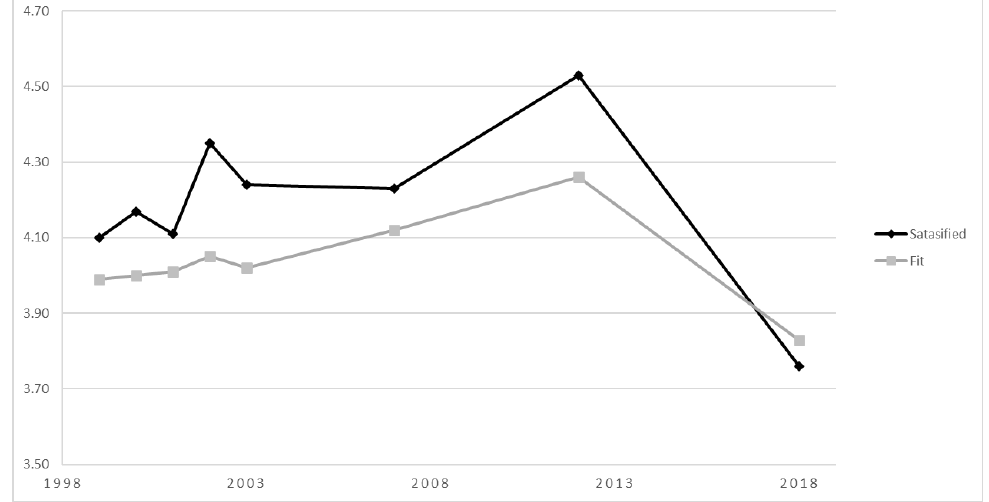
Figure 4 . How Well Respondents Fit in and are Satisfies with Their Community, 1999-2018 Figure 4. How Well Respondents Fit in and are Satisfies with Their Community,